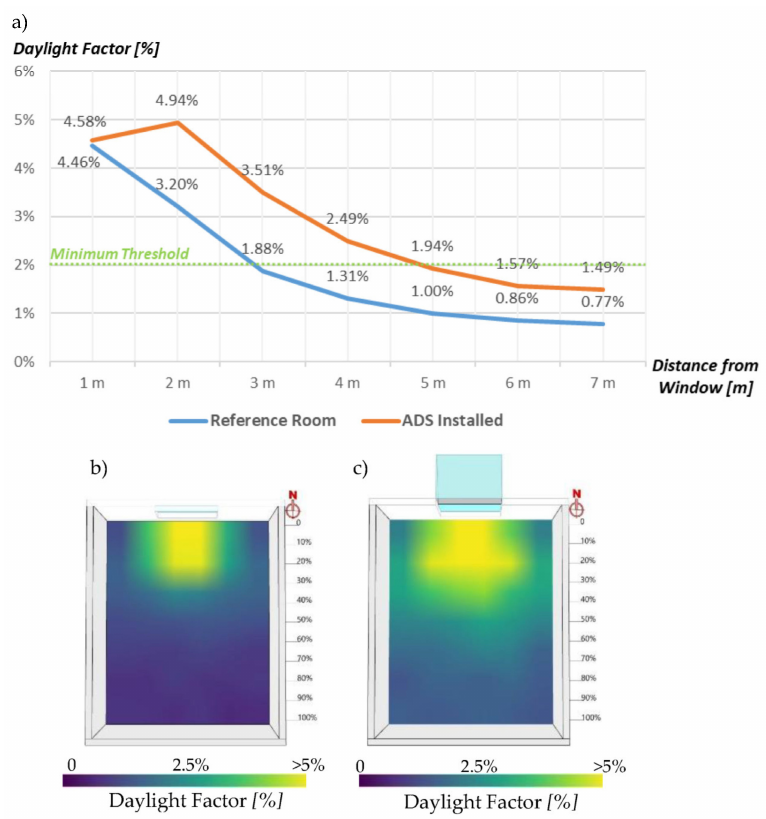
Figure 7. The effect of the ADS on Daylight Factor: ( a ) Comparison; ( b ) Annual DF for the reference room; and ( c ) Annual DF for the ADS-installed room.